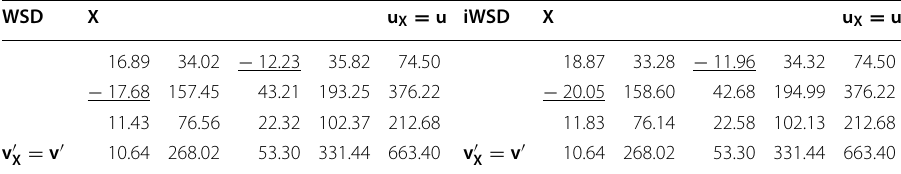
With the same location of underlined matrix elements as in Table 10